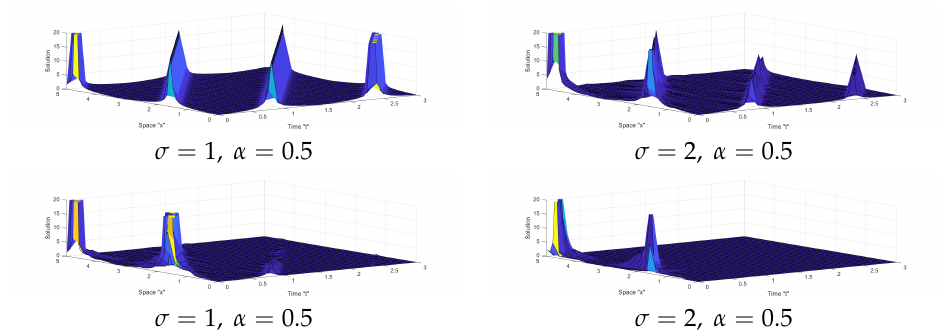
Figure 4. 3D graphs of the equation (31) with α = 0.5.